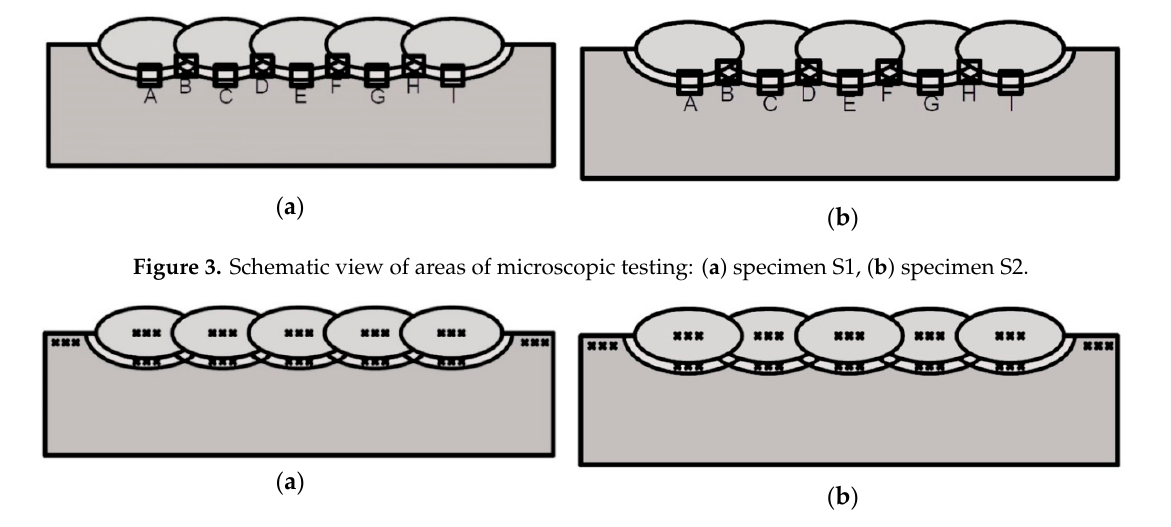
Figure 2. Scheme of welding process in ( a ) specimen S1 and ( b ) specimen S2. Table 3. Welding parameters for specimens S1 and S2.